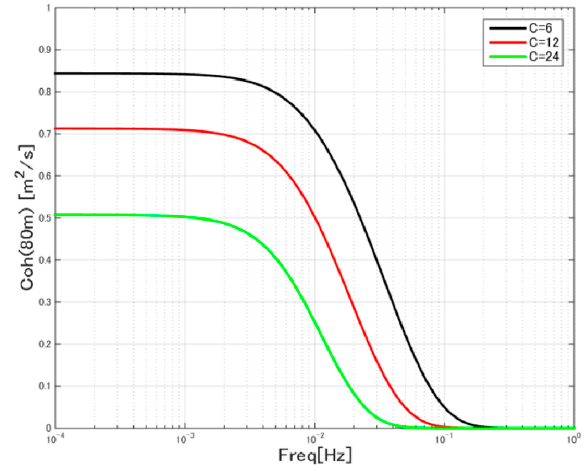
Figure 4. Example of the coherence of the longitudinal wind speed (80 m, 16 m/s).